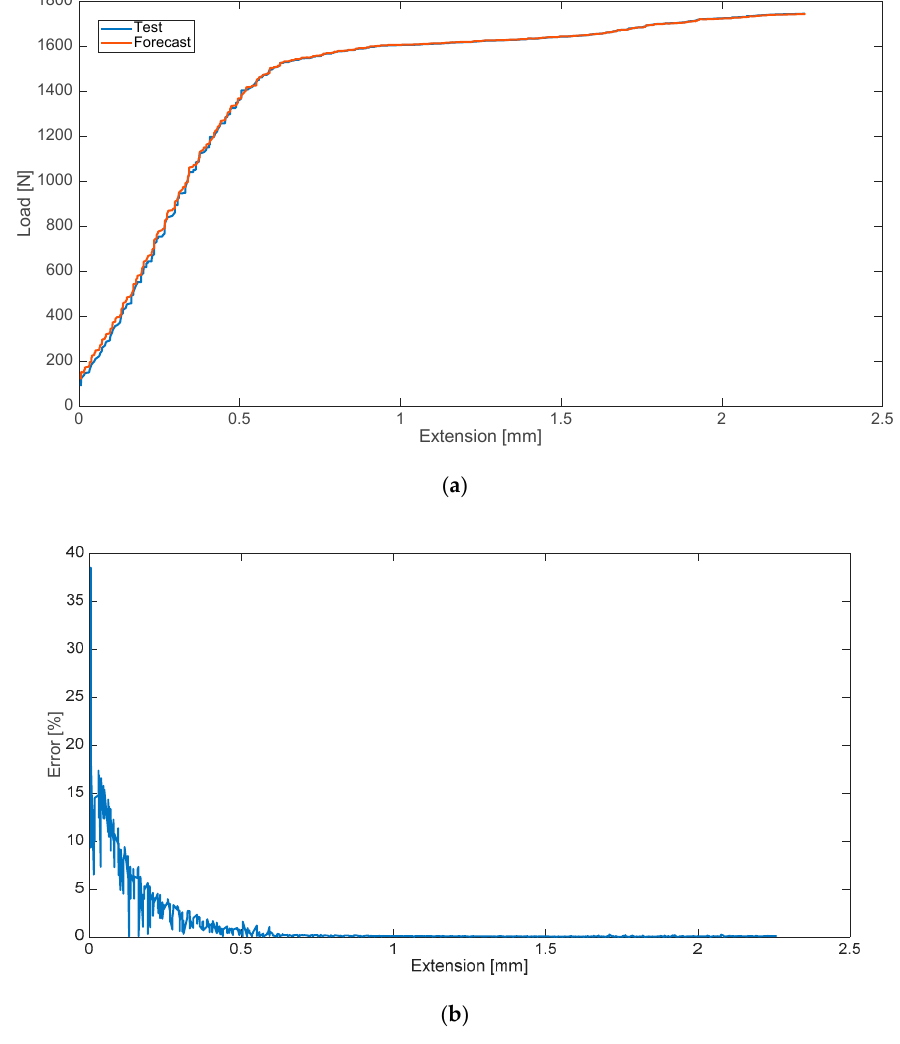
Figure 6. Strength characteristics ( a ) and error values ( b ) for 10% saline admixture.